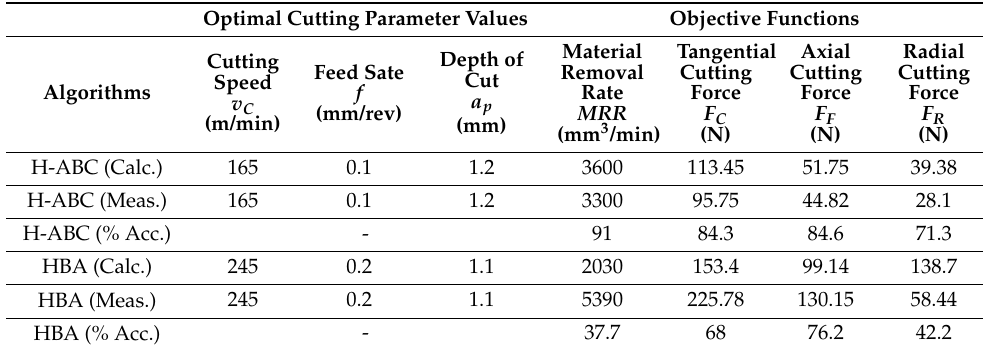
Table 4. The optimization results for HBA and H-ABC.